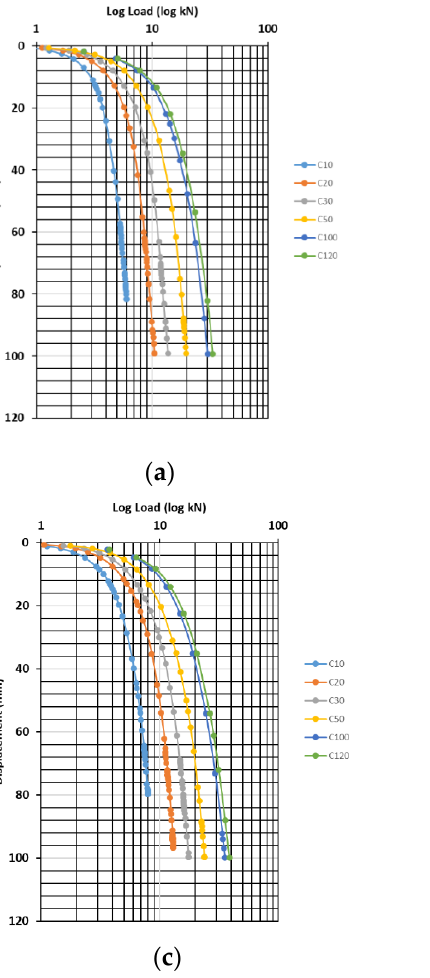
Figure 8. Load versus horizontal displacement for CHSB 1 pile. ( a ) Elasticity modulus of 30 MPa; ( b ) elasticity modulus of 50 MPa; ( c ) elasticity modulus of 80 MPa; ( d ) elasticity modulus of 100 MPa. Table 10. Pile foundation capacity in relation to cohesion of soil for CHSB 1 pile.